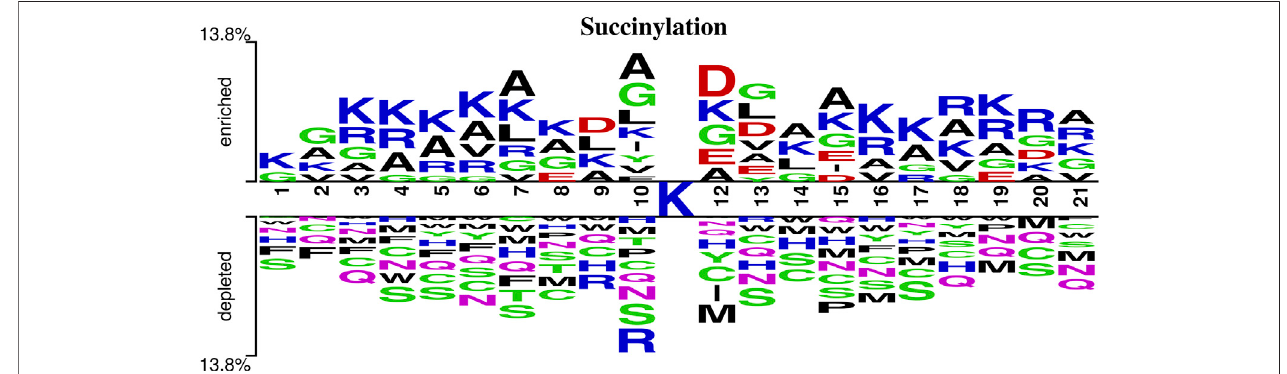
FIGURE 6 | A two-sample logo of succinylation sites against non-succinylation sites. This logo is prepared using the web server http://www.twosamplelogo.org/ and only residues signi fi cantly enriched and depleted surrounding succinylation sites ( t test, p -value < 0.05) are shown.